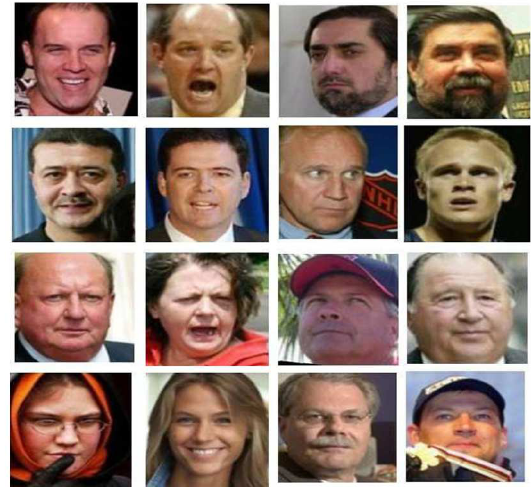
Figure 19. The pairs falsely accepted by the proposed